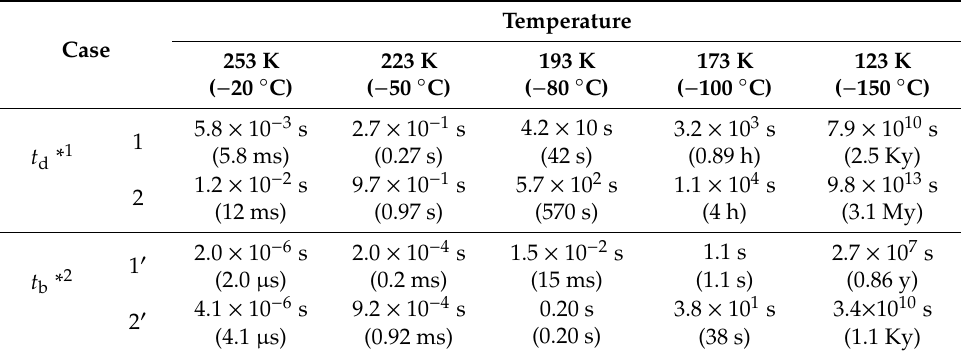
Table 2. Calculated dissociation-completing time t d and dissociation-beginning time t b for basal extended dislocations with Burgers vector < a >.